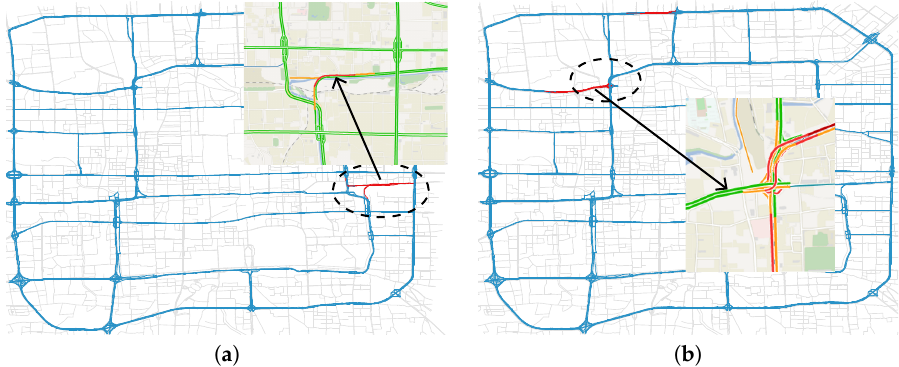
Figure 14. Two types of Context-Evolving Anomaly. The segments indicated by arrow is the test segments, and the area in the dotted oval is the context region. ( a ) Higher volume than neighbors; ( b ) Lower volume than